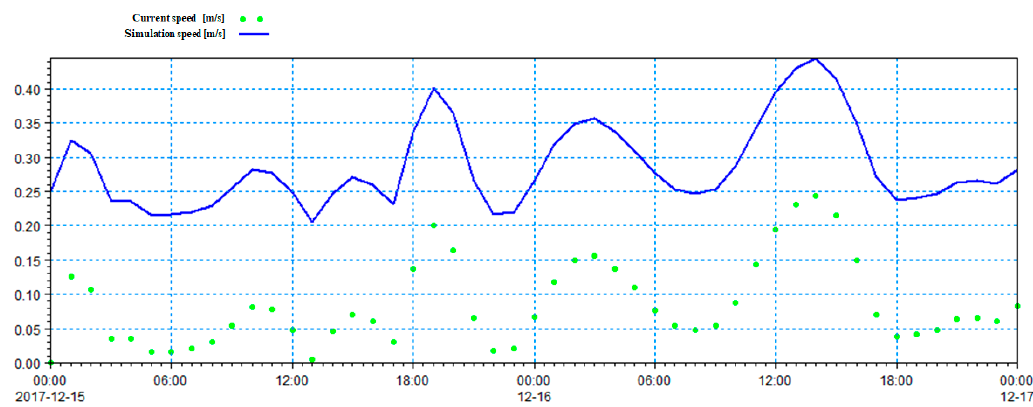
Figure 7. Verification of the comparison of point velocity data.